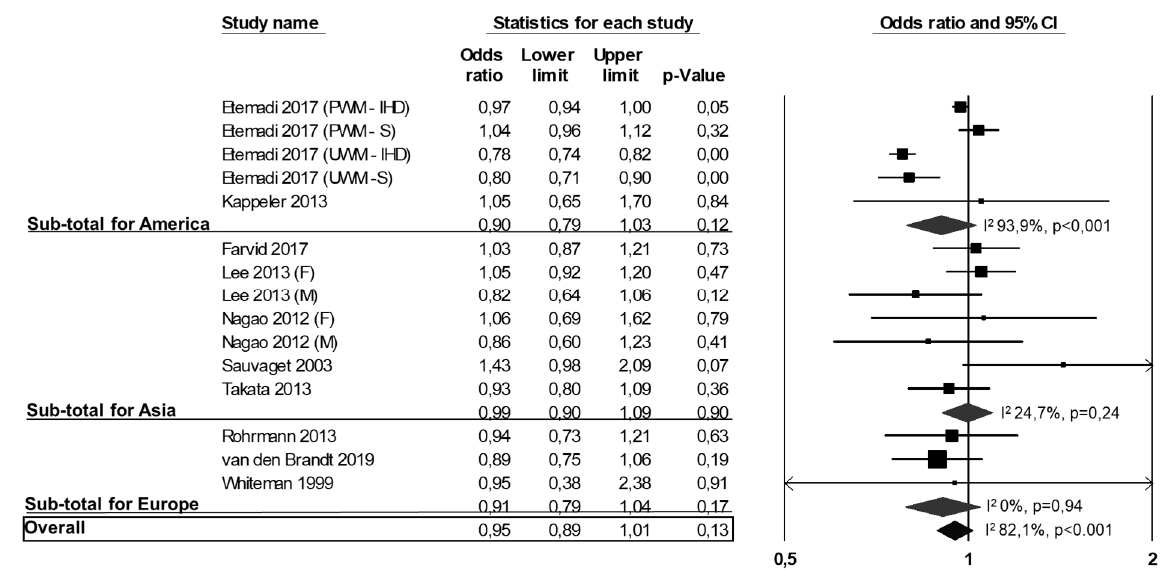
Figure 3. Association between white meat consumption (highest vs. lowest) and CVD mortality. PWD-IHD: processed white meat-ischemic heart disease; PWD-S: processed white meat-stroke; UWM-IHD: unprocessed white meat-ischemic heart disease; UWM-S: unprocessed white meat-stroke; F: females; M: males.